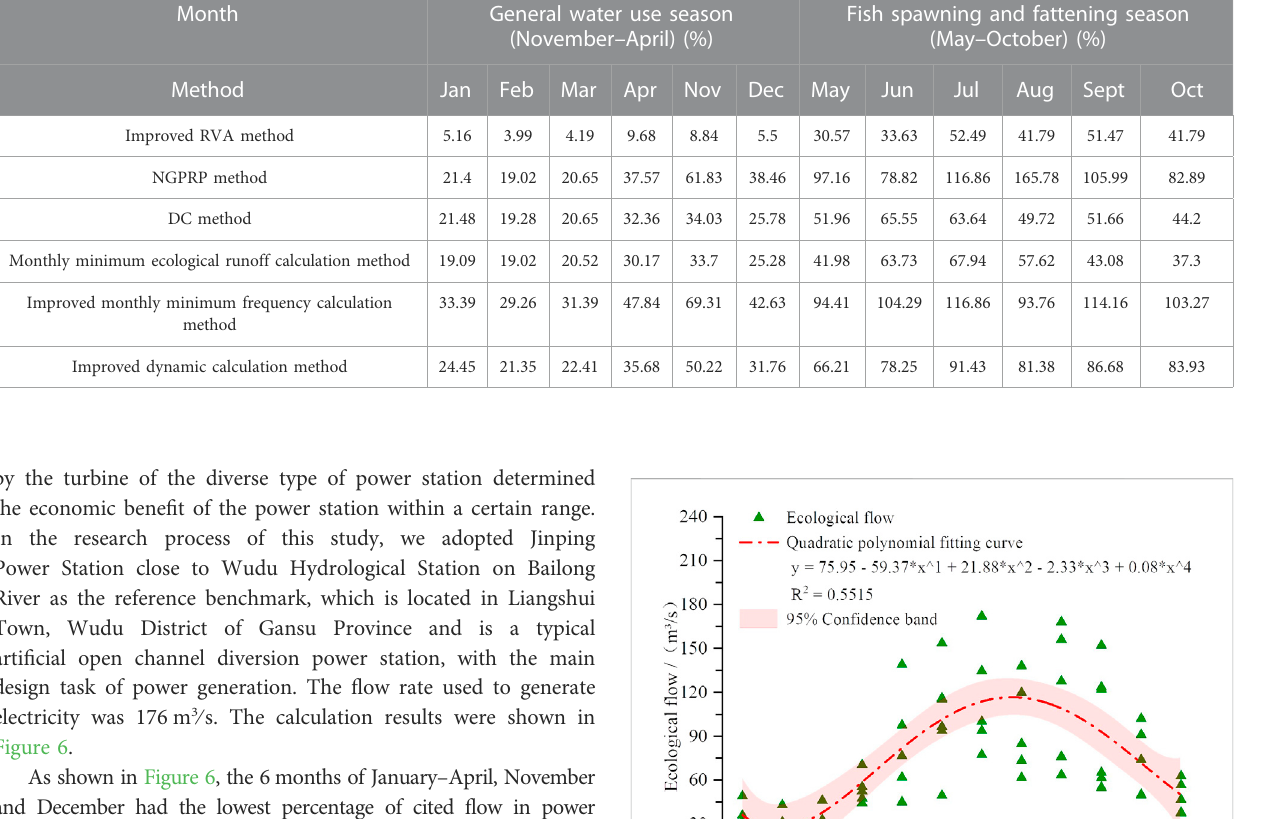
TABLE 6 Tennant method analysis of monthly ecological fl ow within the year. Month